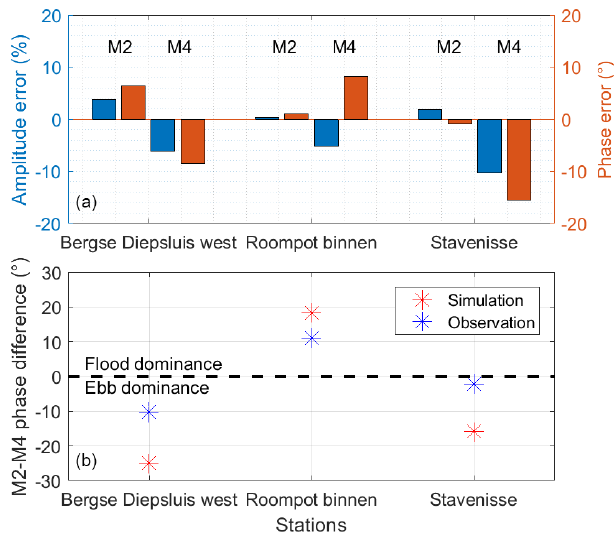
Figure 3. The simulated (a) M2 and M4 amplitude and phase er- rors and (b) M2–M4 phase difference compared to observations. Note that these M2 and M4 tides are calculated based on vertical tides rather than horizontal tides, i.e., different from those in Figs. 6 and 7. Tidal asymmetry is defined based on Friedrichs and Aubrey (1988). See Fig. 1 for the locations of data